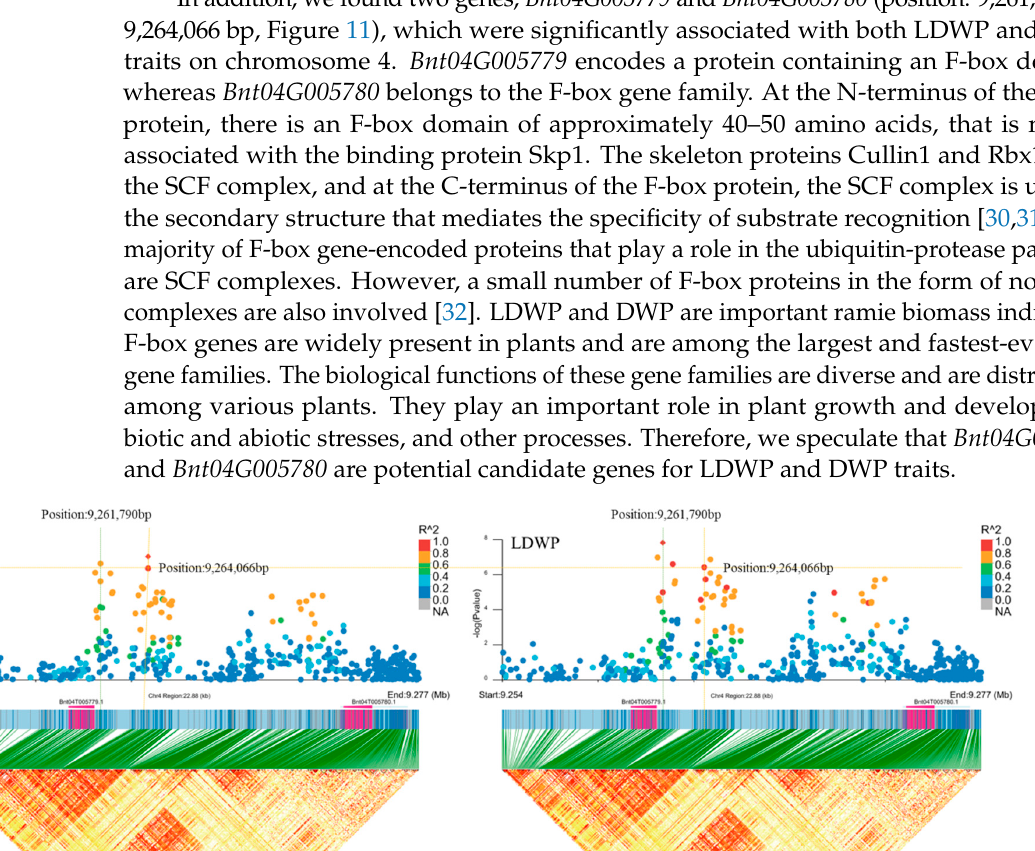
(single nucleotide polymorphism), indicated by an orange dashed vertical line. The larger the Rˆ2 (Coefficient of correlation) values (indicated in the legend on the top right), the stronger the degree of